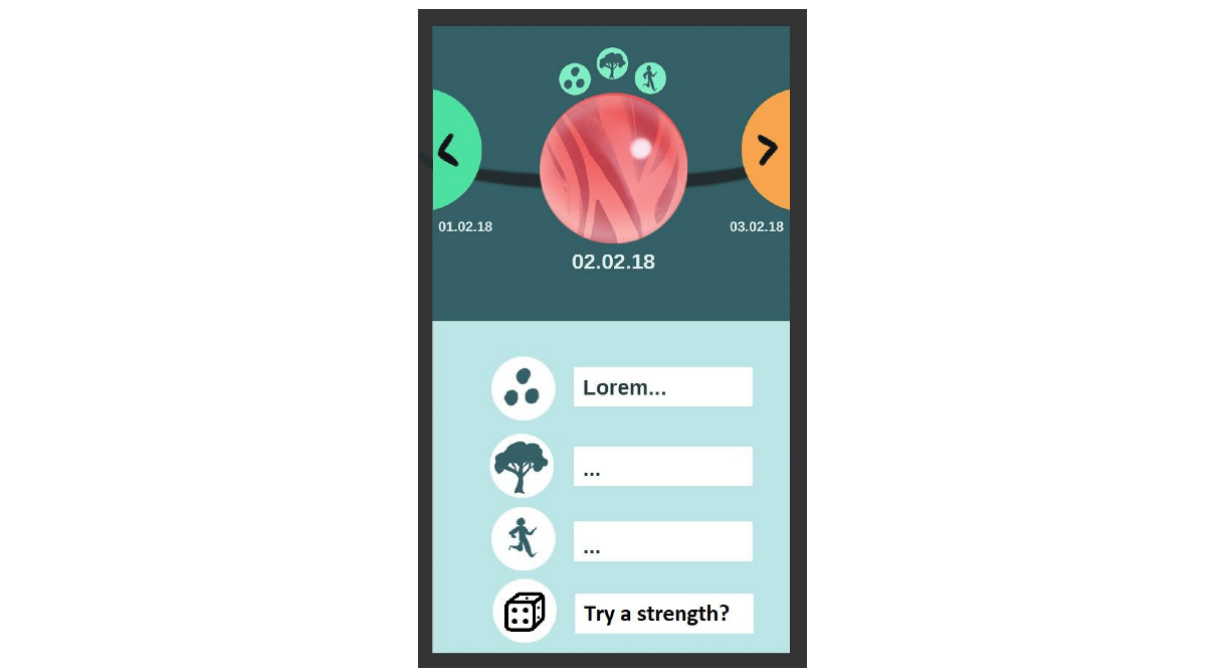
Figure 10. Daily log new concept